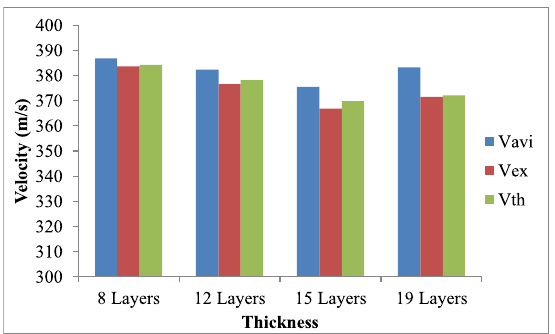
Figure 19. Comparisonofaverageresidualvelocitiesobtainedexper- imentally and calculated analytically with initial velocity for (0/90/45/-45) lay-up plates.